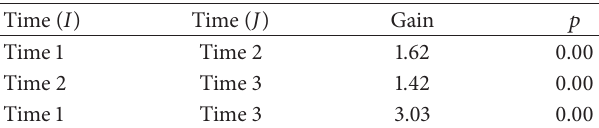
Figure 2: Mean changes of the participants’ scores on productive vocabulary posttests. Table 9: Bonferroni pairwise comparisons for the receptive post- tests.